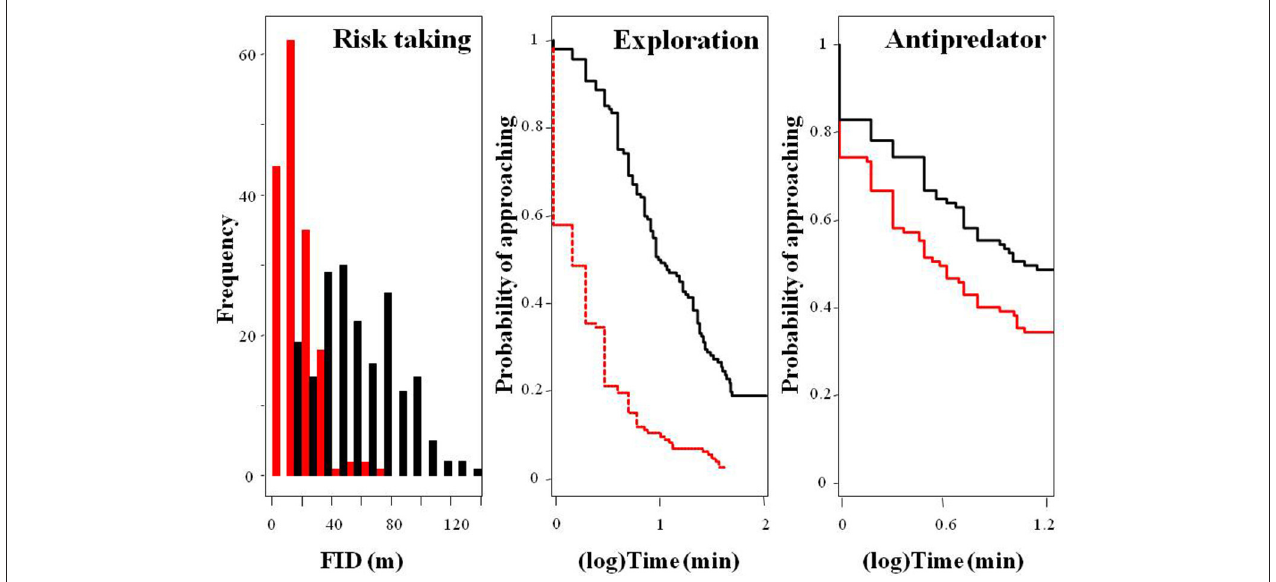
FIGURE 2 | Frequency distribution of fear of humans (risk taking behavior, measured as FID) and survival curves showing the probability of approaching a new feeding source (exploration) or a predator (antipredator) over time among urban (red) and rural (black) burrowing owls.